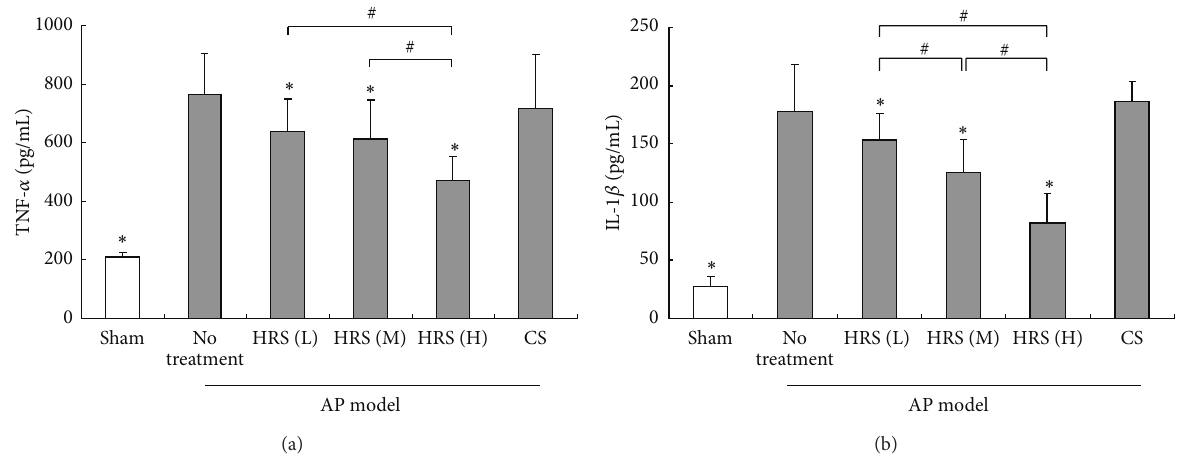
Figure 5: Measurement of plasma cytokines concentration in mice. The HRS at various doses or control saline (CS) was injected intraperitoneally to AP mice 1h after the final injection of cerulein, respectively. One hour later, animals in each group ( 𝑛 = 6 ) were killed and the blood samples were immediately collected. The plasma concentrations of TNF- 𝛼 and IL-1 𝛽 were measured using quantitative ELISA kits according to the manufacturer’s instructions. ∗ 𝑃 < 0.05 , compared with the group of AP mice with no treatment; # 𝑃 < 0.05 , compared in groups of AP mice treated with HRS at different doses; L: low dose (2mL/kg × 3); M: middle dose (4mL/kg × 3); H: high dose (8 mL/kg ×